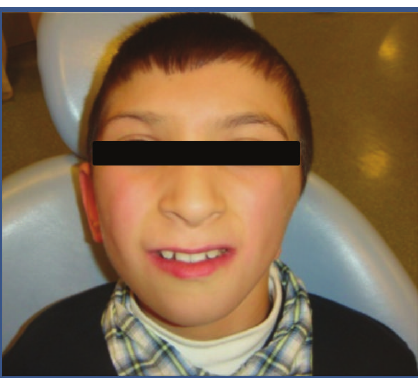
Figure1:Craniofacialanomaliespresentincludedhemifacialatrophy,maxillomandibularhypoplasia,severemicrognathia,malarhypoplasia, flat nasal bridge, and left ear canal atresia.